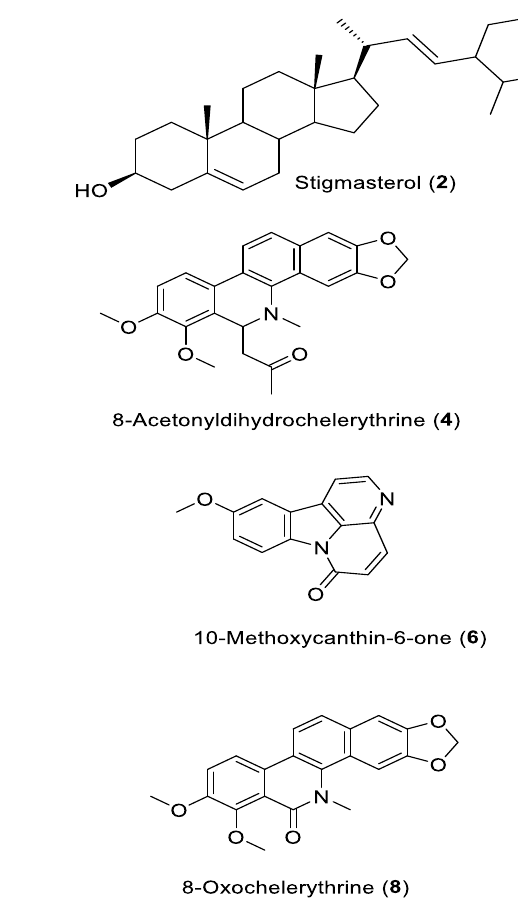
Figure 1. Structures of compounds ( 1–8 ) isolated from root bark of Zanthoxylum paracanthum.